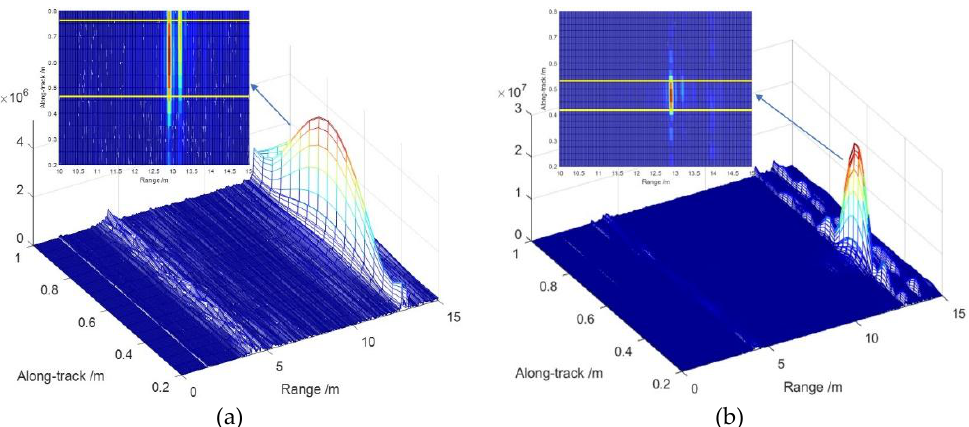
Figure 14. Imaging output and target size comparison: imaging results from ( a ) MBES of the middle beam, and ( b ) MBSAS of the middle beam. beam, and ( b ) MBSAS of the middle